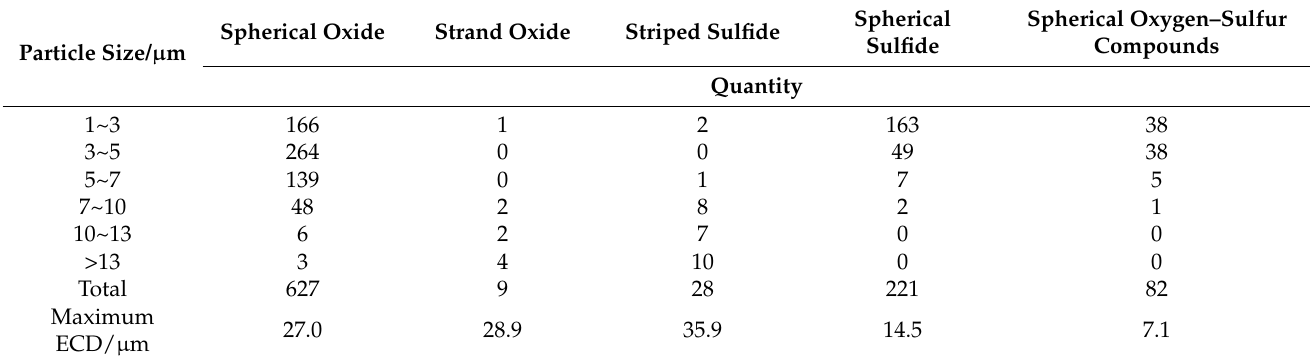
Table 7. Results of the particle size distribution of inclusions in 100 mm 2 of Sample 1#.